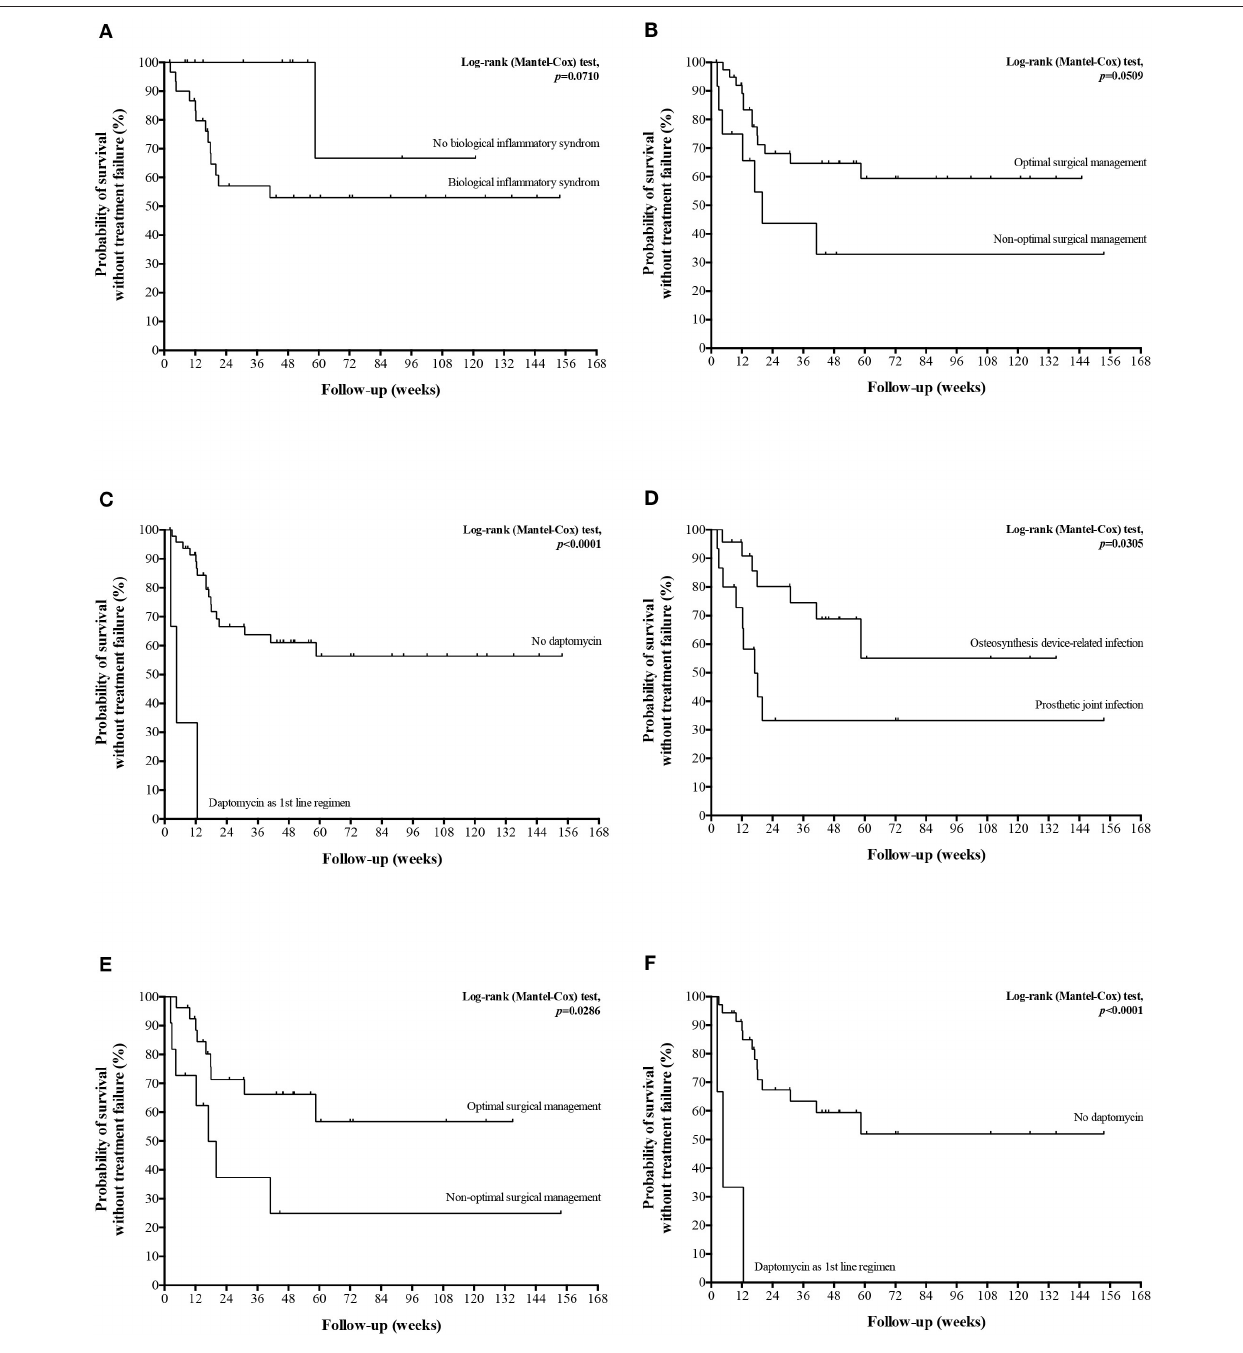
The short time of follow-up (less than a year) of patients without treatment failure is not enough to affirm treatment success and represent another limitation to this study. However, even if relapses have been described several months/years after the end of therapy, this represents a rare